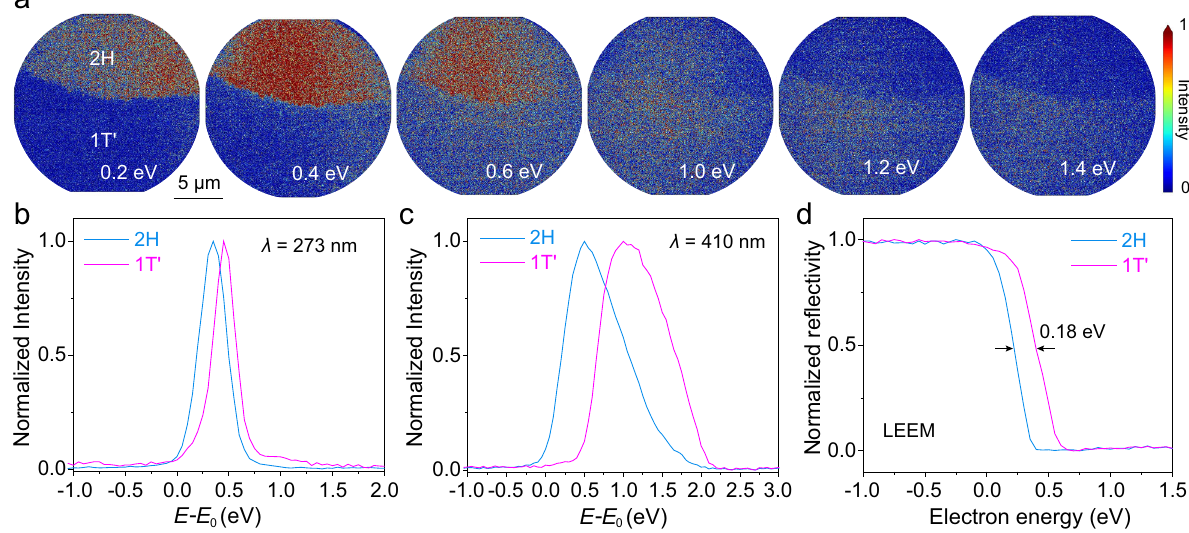
Fig. 2 Energy distribution of photoexcited electrons at the 1 T ′ /2H-MoTe 2 heterojunction. a PEEM images recorded at different energies under the illumination of 410 nm pulsed laser. Scale bar is 5 μ m. b Normalized photoelectron spectroscopy illuminated by the 273 nm pulsed laser with a fl uence of ~0.27 μ J/cm 2 . c Normalized photoelectron spectroscopy illuminated by the 410 nm pulsed laser with a fl uence of ~28 μ J/cm 2 . “ E – E 0 ” indicates the kinetic energy of the photoemission electrons. d Electron re fl ectivity curves measured by the LEEM, indicating the work function of 1 T ′ -MoTe 2 is about ~0.18 eV higher than that of the 2H-MoTe 2 .